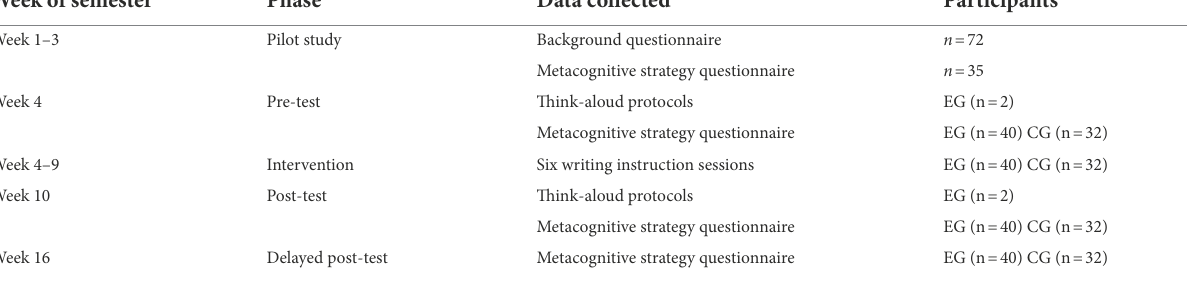
TABLE 1 Data collection procedure.